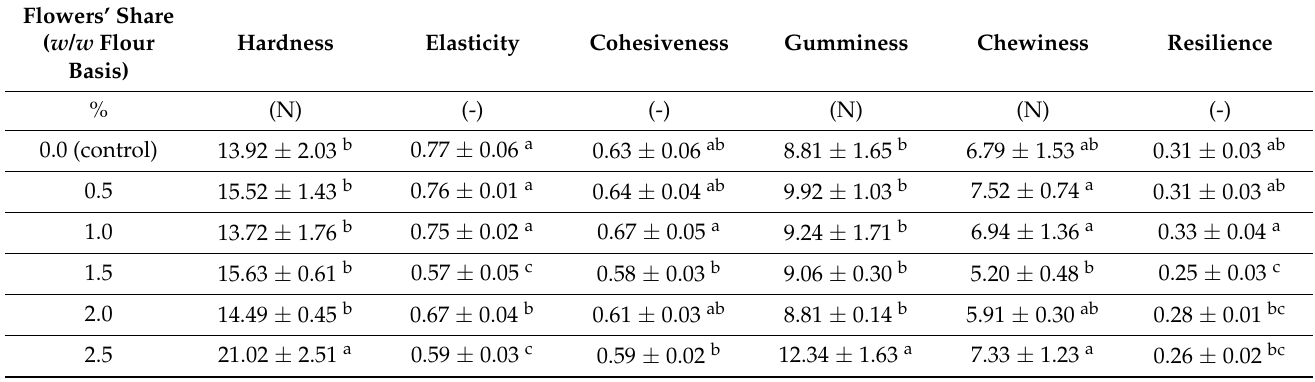
Table 5. Textural parameters of wheat bread enriched with J. regia male